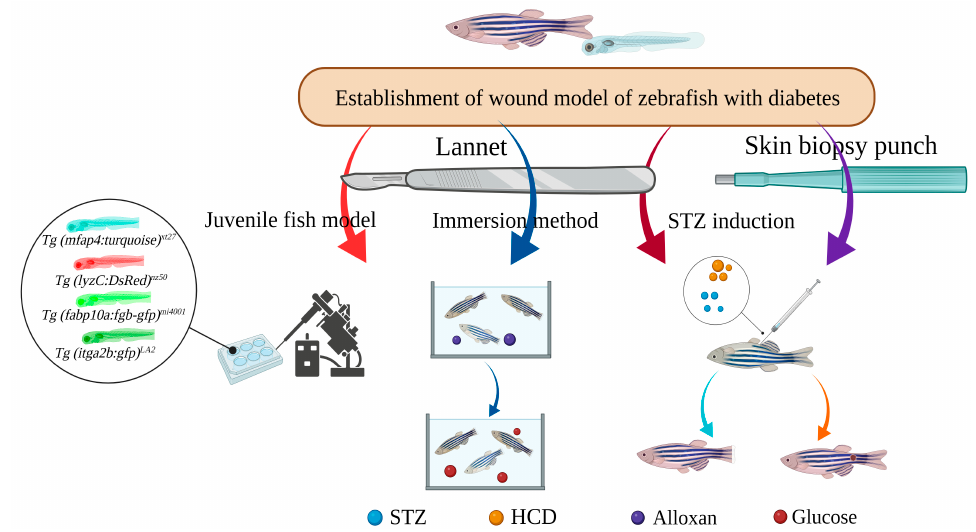
Figure 4. Application of zebrafish and their larvae in diabetic wounds. 4.1. STZ-Induced Caudal Fin Regeneration Model of Zebrafish with Type 1 Diabetes Zebrafish respond efficiently and rapidly to streptozotocin (STZ) injection induced diabetes, and hypercholesterolemia caused by high cholesterol diet (HCD)—associated with a high risk of DFUs) Cho et al. [92] injected 30 μ L 5 mM citrate buffer containing 0.3% STZ into the subcutaneous tissue adjacent to the abdomen for eight consecutive days uti- lizing a 26-needle micro-syringe. Prior to that, they were given a 4% cholesterol high cho- lesterol diet (HCD) for 4 weeks, consisting of normal diet (ND) alone group, ND+STZ group, HCD alone group. and HCD+STZ group. Finally, patients were treated with Heberprot-P75 ® , Easyef ® (two commercial epidermal growth factor (EGF) products, intra- peritoneal injection of 10 μ L, 50 μ g/mL) and PBS on day 3, 5 and 7, respectively. As a result of treatment with PBS in the ND+STZ and HCD+STZ groups, adult fish showed serious delays in healing, as well as multiple cracks which is the typical damage pattern induced by STZ injection in diabetic zebrafish on their caudal fins. However, no cracks appeared in the HCD alone group [93]. Heberprot-P75 ® showed caudal fin regeneration activity 2.1 times higher than Easyef ® (ND+STZ group) and 1.7 and 1.5 times higher than the Easyef ® group and PBS group (HCD+STZ group) under the same injection and amputation regi- men, with more distinct and clean regeneration modes [93]. Intine et al. injected 0.35 mg/g of STZ intraperitoneally for 1, 3, and 5 days and maintained the injection weekly with the tank temperature maintained at 22–24 °C, as well as amputating the caudal fin in a straight line using a sterile size 10 scalpel, proximal to the first lepidotrichia branching point to obtain an adult zebrafish wound model of type I diabetes bearing an average blood glu- cose of more than 300 mg/dL, impaired caudal fin regeneration, accumulation of AGEs, and epigenetic changes including genome-wide demethylation. At 21 days to stop the in- jection of STZ, and restore normal blood insulin and glucose control through pancreas regeneration, and obtain the metabolic memory (MM) fish, whose limb regeneration was still the same as the state of acute diabetes damage, even at 30, 60, 90 days, and this affects the genetic to daughter cells [11], as well as bnormal DNA methylation was also retained, but AGEs did not accumulate and ROS induced stress signals did not increase. In conclu- sion, restoring physiologically normal glycemic control may not save altered target tissue from diabetes-induced changes [94]. Microarray transcript analysis was also performed applying this model and revealed abnormal expression of the following genes in T 0 : (1) developmental transcription factors (such as SOX3 , emx2 , dlx4a , etc.), (2) DNA modifica- tion related genes ( DNMT1 , apex1 , MCM2 , uhrf1 , etc.), and (3) stress response/trauma re-